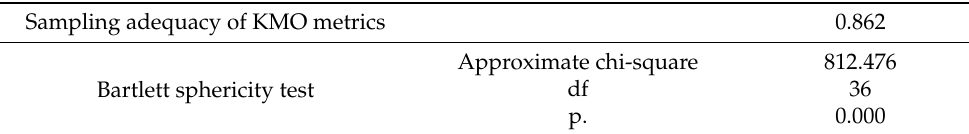
Table 8. KMO and Bartlett Tests of Perceived Leader Trust.